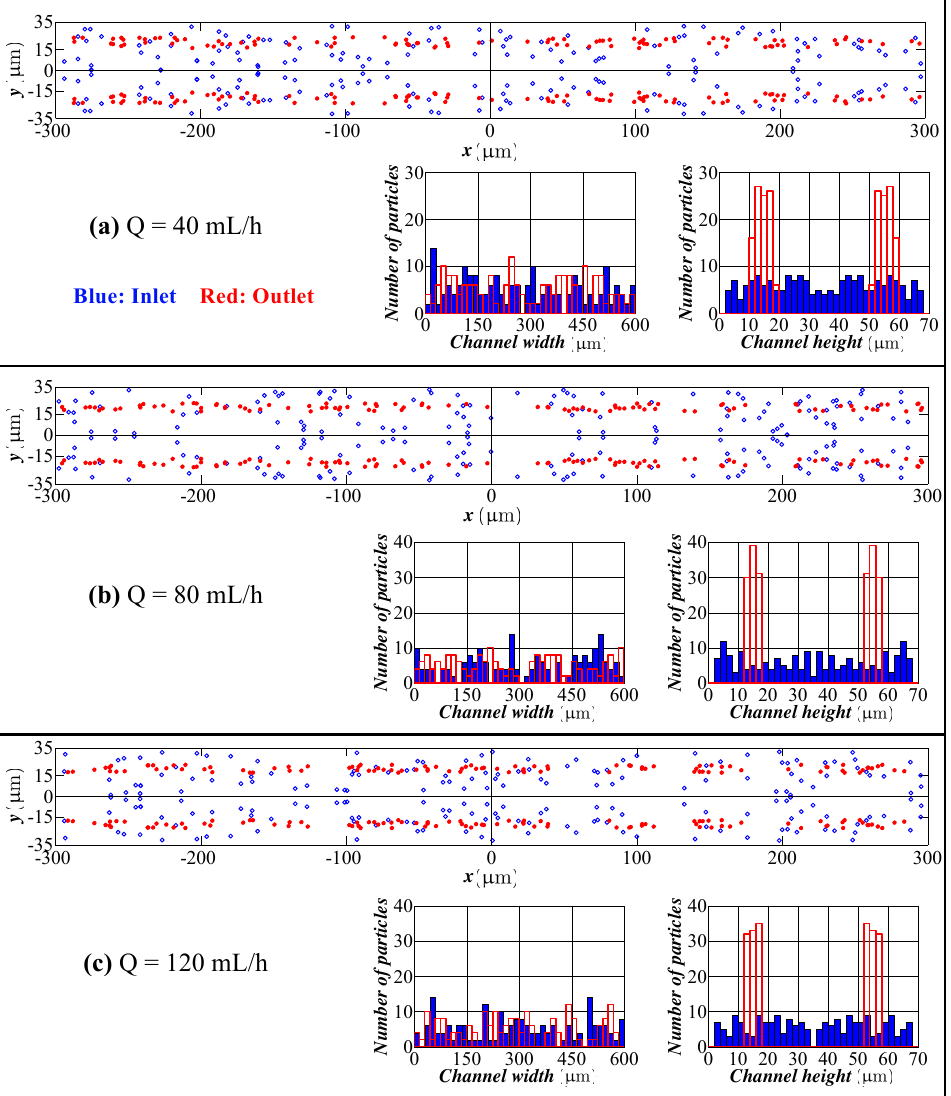
Figure 5. Particle distribution at the inlet and outlet in the height and width directions for different flow rates (spiral channel with an AR 9.0, 2.0 µ m particles). Flow rate: ( a ) 40 mL/h; ( b ) 80 mL/h; ( c ) 120 mL/h. Blue bars: particle distribution at the inlet. Red bars: particle distribution at the outlet. Figure 6 shows the cross-sectional view and distribution of particles at the inlet and outlet of the channel for 10 µ m particles. According to these results, 10 µ m particles are focused on the long axis of the channel in the vicinity of the inner wall. For a straight channel with an AR of 2.0, 10 µ m particles focus on the long axis of the channel and are symmetrically placed in the vicinity of two vertical walls [43]. Thus, in the spiral channel, particles also focus on the long axis. The existence of secondary flow just relocates the particles’ equilibrium position. Unlike the straight channel in which there are two symmetric equilibrium positions, the spiral channel has only one equilibrium position, which can be attributed to the existence of secondary